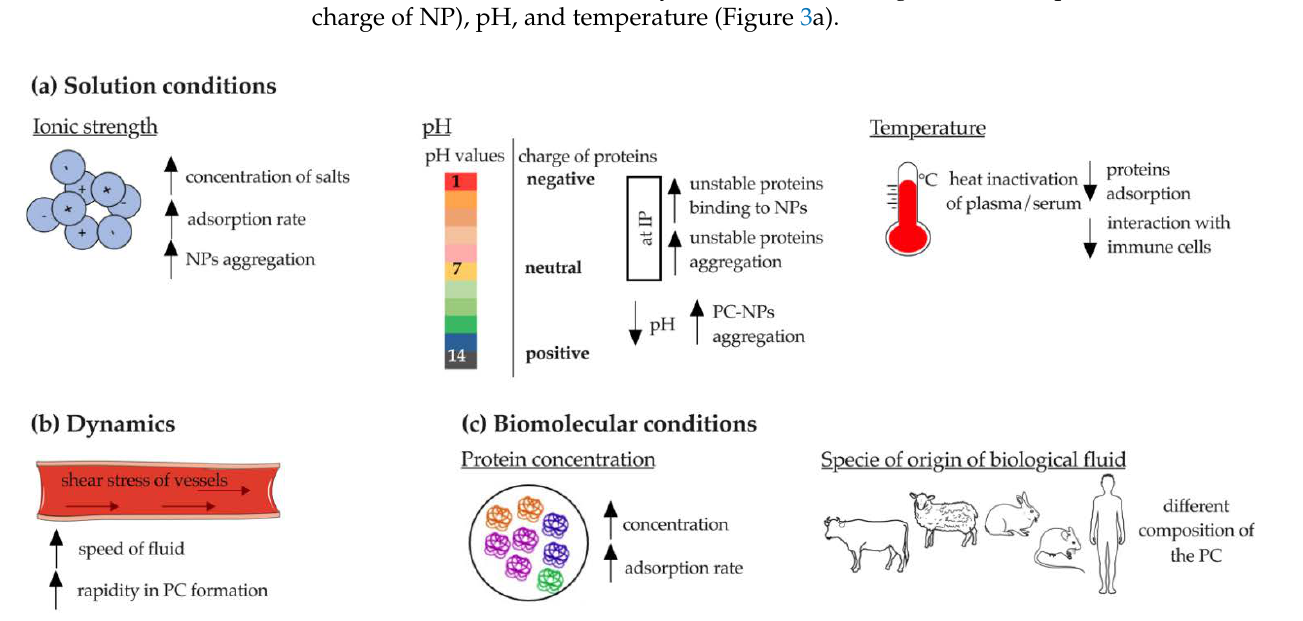
Figure 3. Schematic representation of extrinsic factors affecting the protein corona formation. ( a ) Solution conditions; ( b ) dynamics and ( c ) biomolecular conditions. PC: protein corona: IP: isoelectric point. The figure was partly generated using Servier Medical Art by Servier, licensed under the Creative Commons Attribution 3.0 Unported Licence.